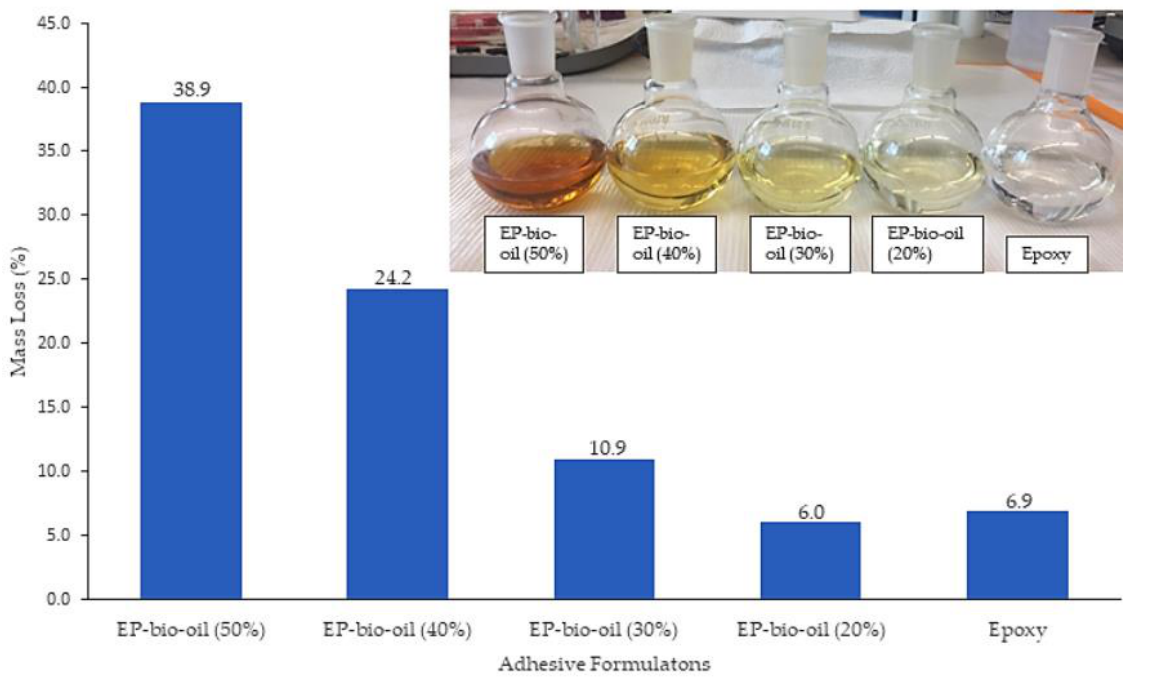
Figure 3. Mass loss (wt.%) of cured epoxy and epoxy-substituted bio-oil resin system under acetone extraction for 6 h.